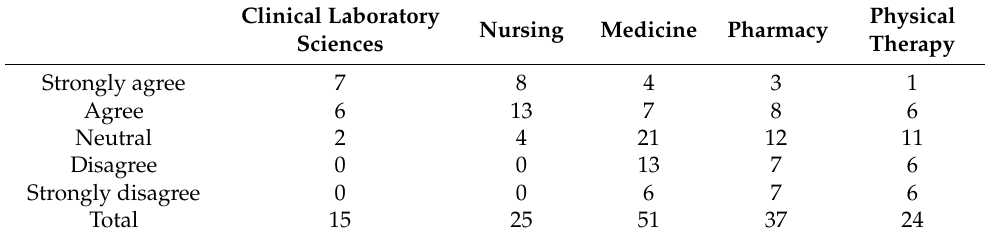
Table 3. Distribution of student responses to item no. 18 of RIPLS questionnaire per profession.